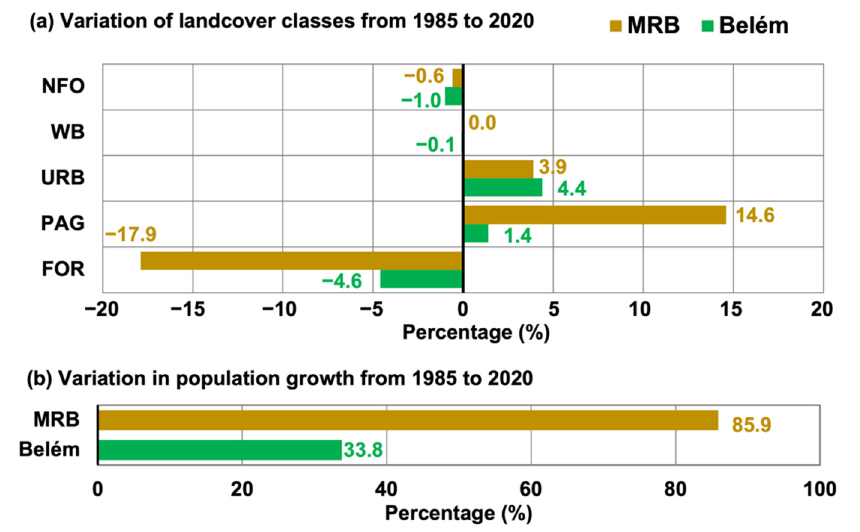
Figure 9. The 1985 to 2020 percentage changes for Belém (green) and MRB (brown) in the ( a ) land-cover classes; ( b ) population growth.